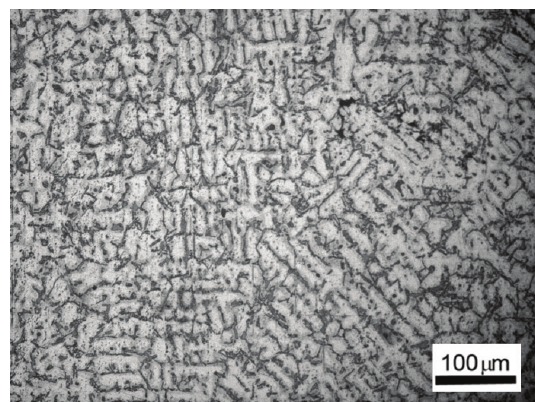
Figure 5. Variation of the bulk porosity of the CS cast ingots with the pouring temperatures.